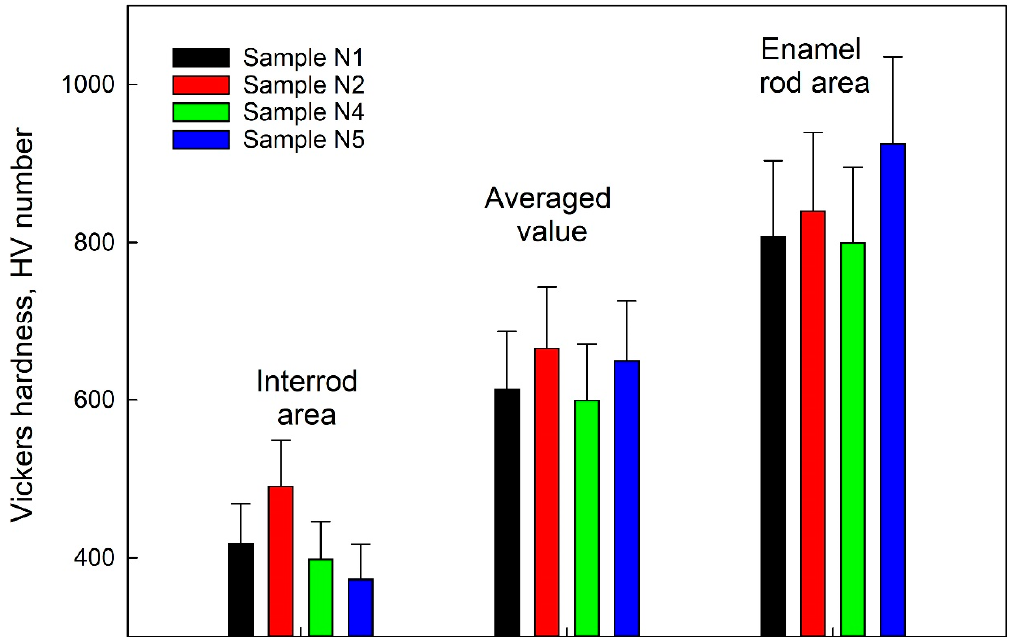
Figure 13. Vickers hardness in units of HV for the studied samples in the enamel rods area and inter-rods area, as well as the averaged value for a particular type of sample. The diagram shows the mean value of the Vickers hardness and the standard deviation.